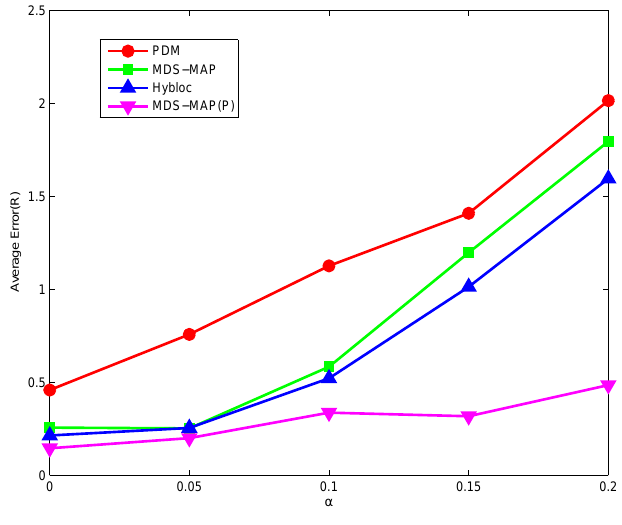
Figure 13 . 5 Clustered Anchors, Average Connectivity=17.16, Uniform